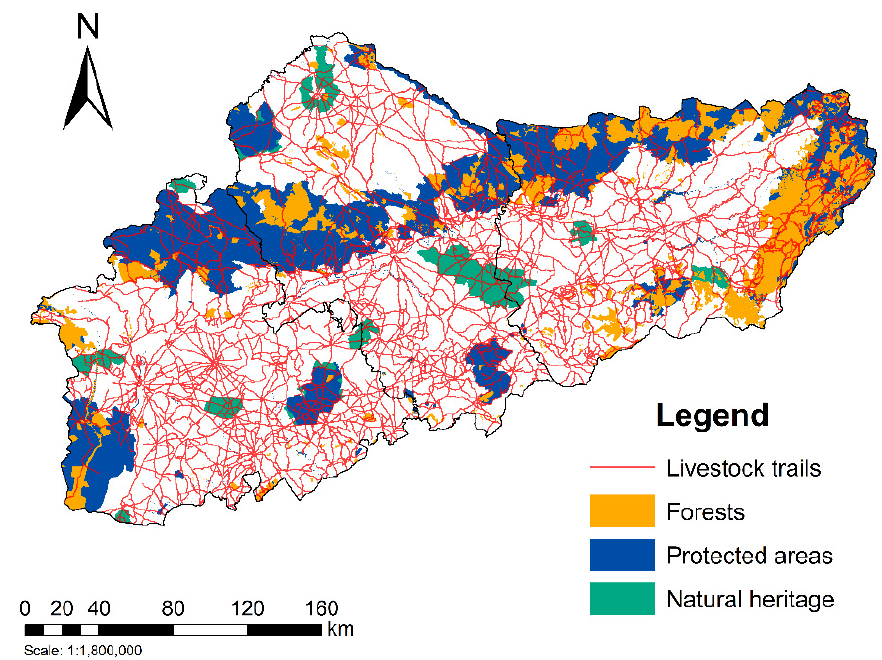
Figure 4. Map of protected natural areas.